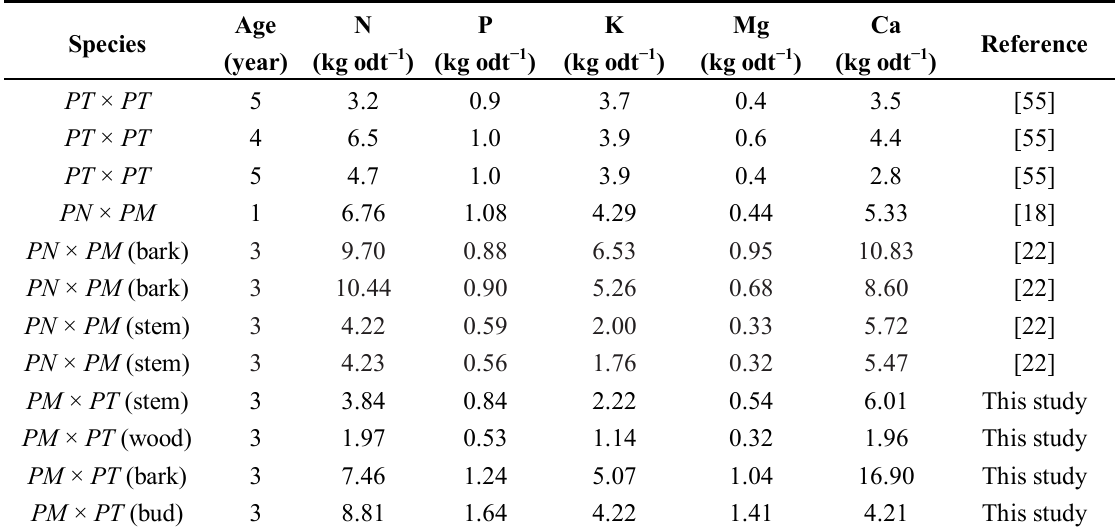
Table 7. Estimated elemental content in above ground biomass of selected poplar